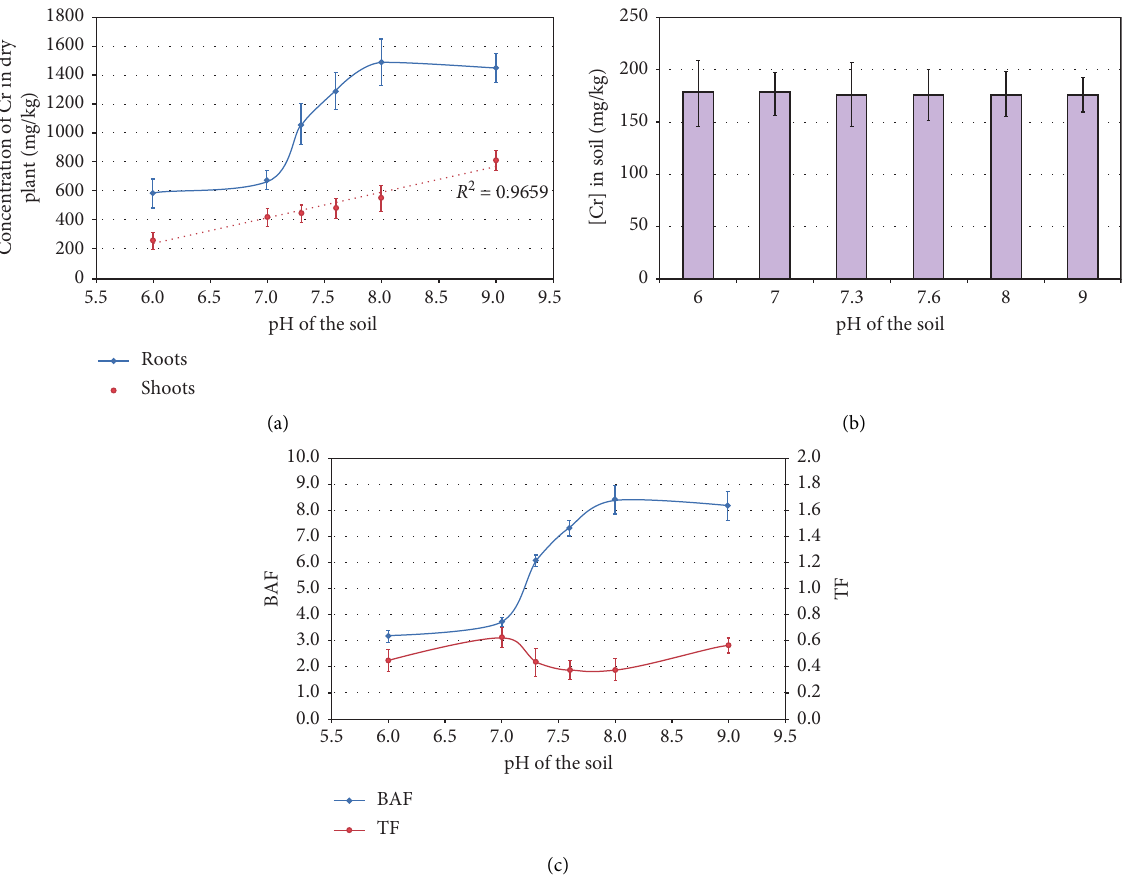
Figure 3: Change in concentration of total chromium (a) in the roots and shoots and (b) in the soil; (c) change in bioaccumulation and translocation factors of P. oleracea versus pH of the soil (mean of six replicates ± SE, 95%